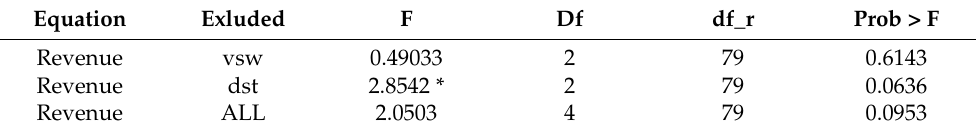
Table 8. Space weather and power station revenue.